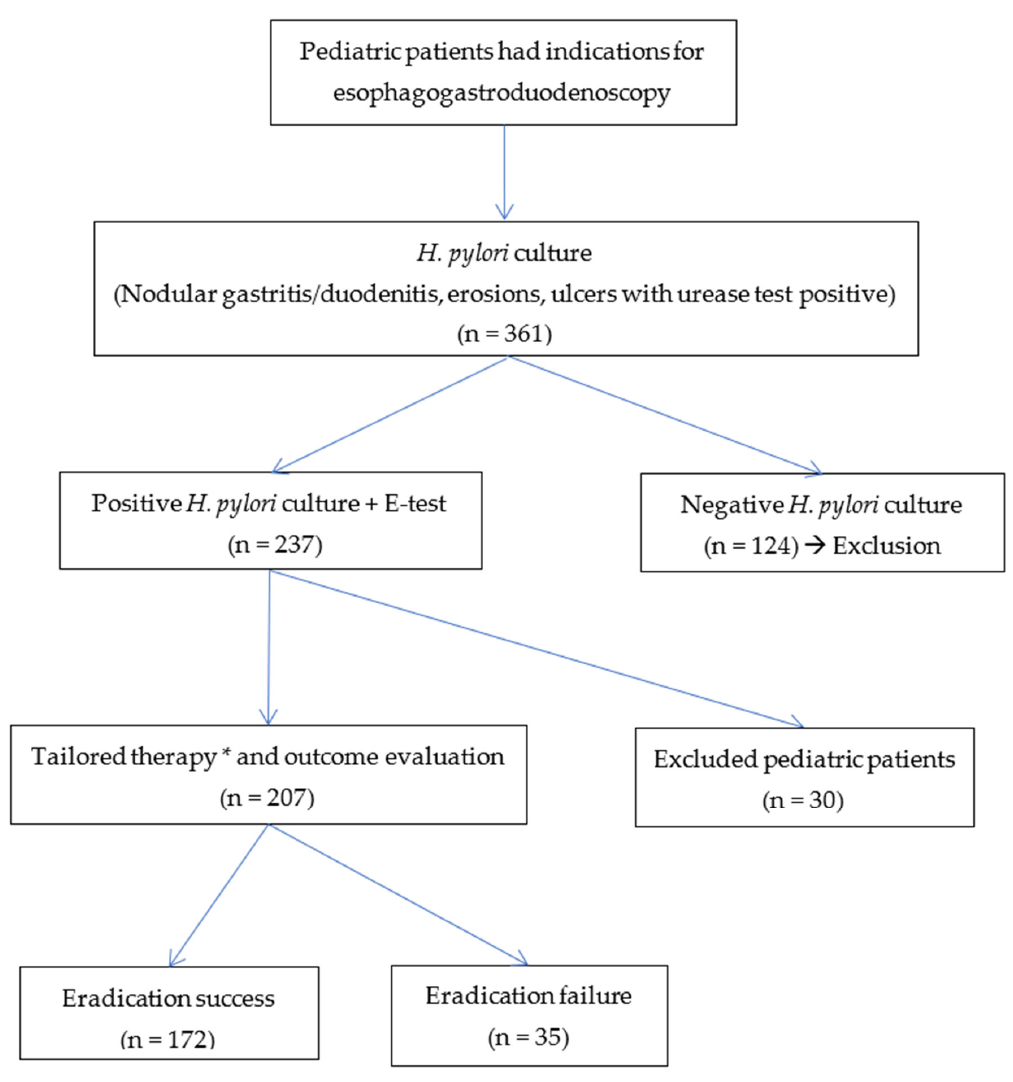
Figure 1. The diagnosis and eradication therapy of Helicobacter pylori in the